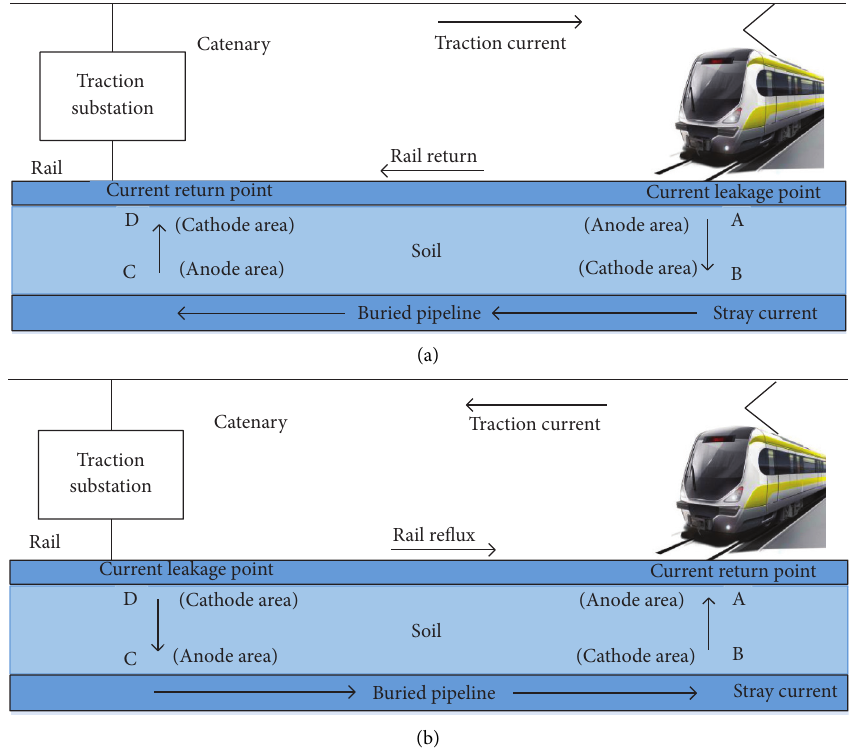
Figure 5: Electrochemical corrosion caused by stray current. (a) Train traction current is positive. (b) Train traction current is